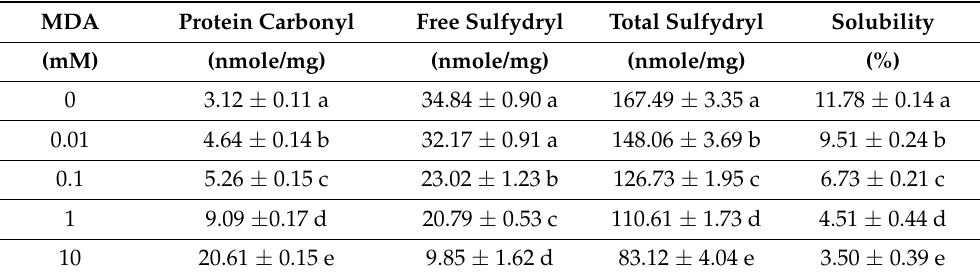
Table 1. Protein carbonyl, free sulfhydryl, total sulfhydryl, and solubility of walnut protein incubated with different concentrations of MDA. MDA Protein Carbonyl Free Sulfydryl Total Sulfydryl Solubility